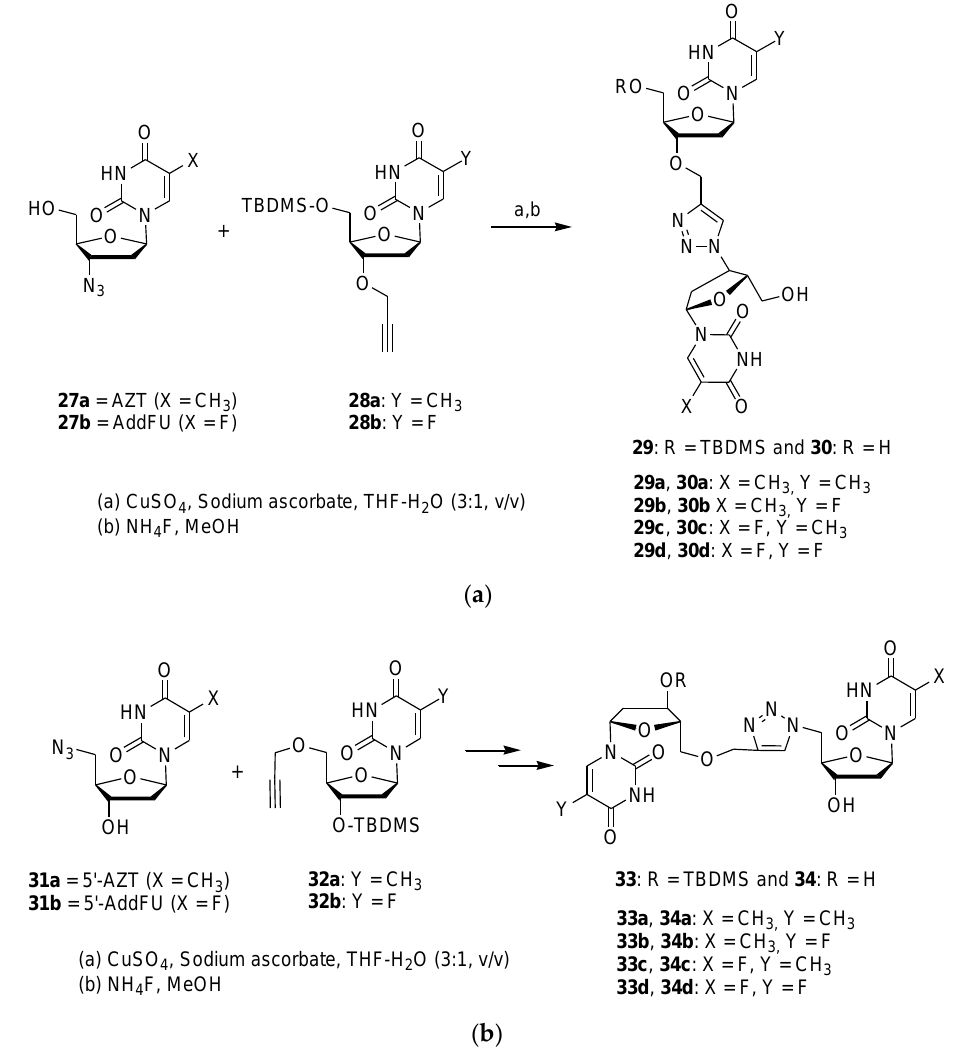
Figure 8. ( a ) Click chemistry synthesis of dimers 30a – d by combination of 3 (cid:48) -azido-nucleosides and 3 (cid:48) -O-propargyl- nucleosides. AZT, 3 (cid:48) -azido-3 (cid:48) -deoxythymidine ( 27a ); AddFU, 3 (cid:48) -azido-2 (cid:48) ,3 (cid:48) -dideoxy-5-fluorouridine ( 27b ). ( b ) Click chemistry synthesis of dimers 34a – d by combination of 5 (cid:48) -azido-nucleosides and 5 (cid:48) - O -propargyl-nucleosides; 5 (cid:48) -AZT, 5 (cid:48) -azido-5 (cid:48) -deoxythymidine ( 31a ); 5 (cid:48) -AddFU, 5 (cid:48) -azido-2 (cid:48) ,5 (cid:48) -dideoxy-5-fluorouridine ( 31b